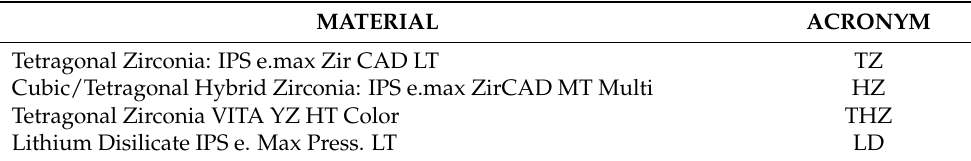
Table 1. Characterized materials and their acronyms. MATERIAL ACRONYM Tetragonal Zirconia: IPS e.max Zir CAD